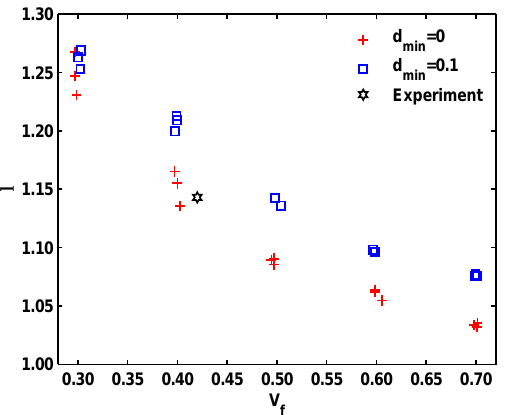
Figure 3. The normalized average nearest inter-fiber distance with the volume fraction of fiber.